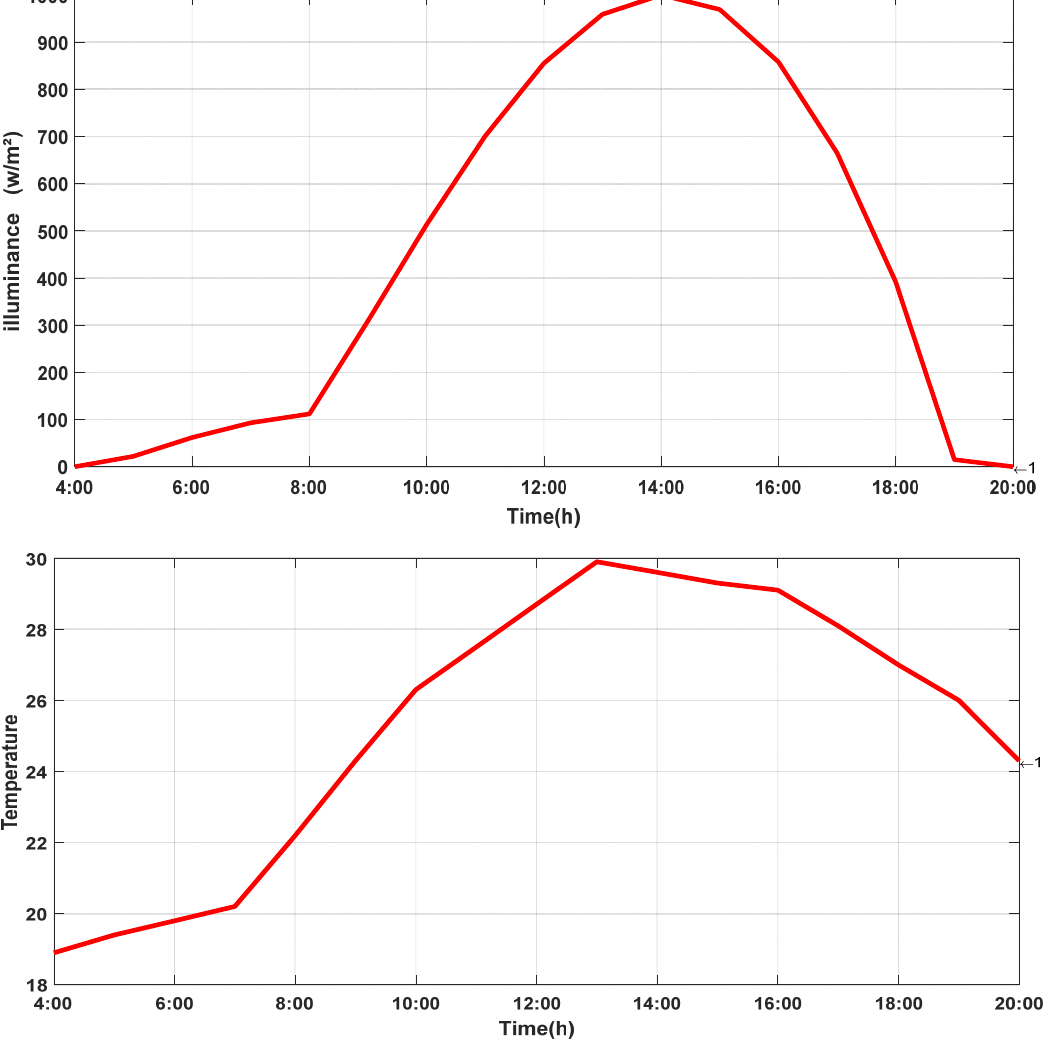
Figure 11. ( a ) Temporal variation of irradiance during a day. ( b ) Temporal variation of temperature during a day.